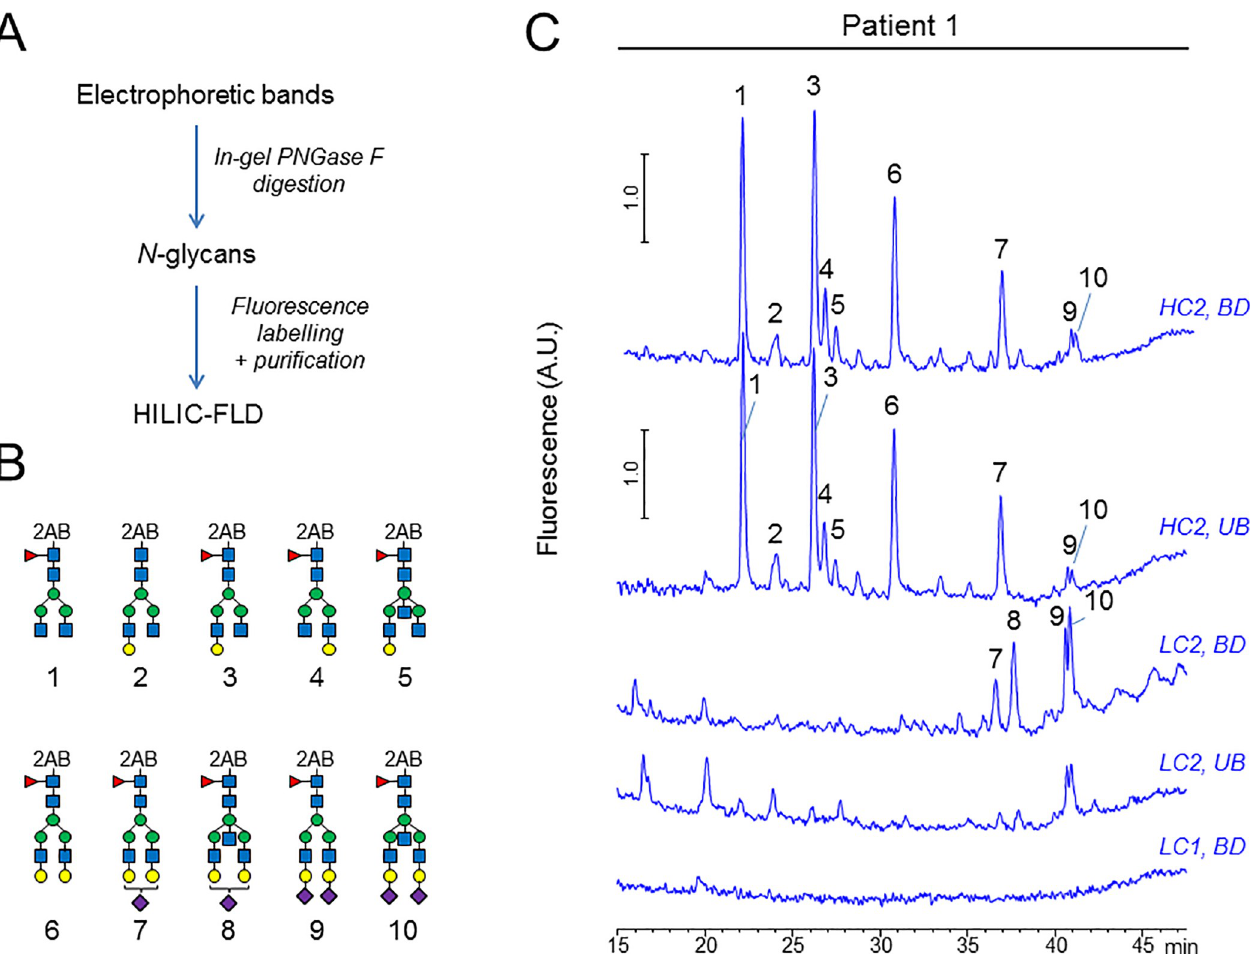
Fig 6. Carbohydrate profile of anti-MPO-enriched IgGs relative to unbound fraction. A: Glycans were released by in-gel PNGase F treatment and labeled with 2-aminobenzamide. The labeled glycans were separated by HPLC with fluorescence detection. B: Structures of the most abundant 2-AB labeled glycans detected with numbers corresponding to the respective peaks on each chromatogram. C: Glycosylation profiles obtained for the anti-MPO enriched (BD) and anti-MPO depleted (UB) materials. 2AB: 2-aminobenzamide, blue square: N -acetyl glucosamine, red triangle: fucose, green circle: mannose, yellow circle: galactose, purple diamond: N -acetyl neuraminic acid (sialic acid), LC: light chain, HC: heavy chain, UB: unbound fraction (anti-MPO depleted IgG), BD: bound fraction (anti-MPO enriched IgG), HILIC: Hydrophilic interaction chromatography.